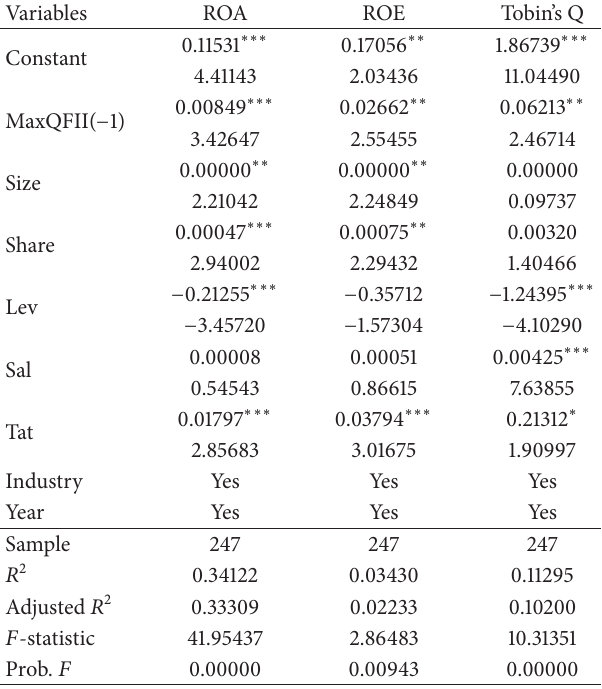
Table 5: Regression results of QFII investment ratio in period ( 𝑡−1 ) and company performance according to MODEL I.